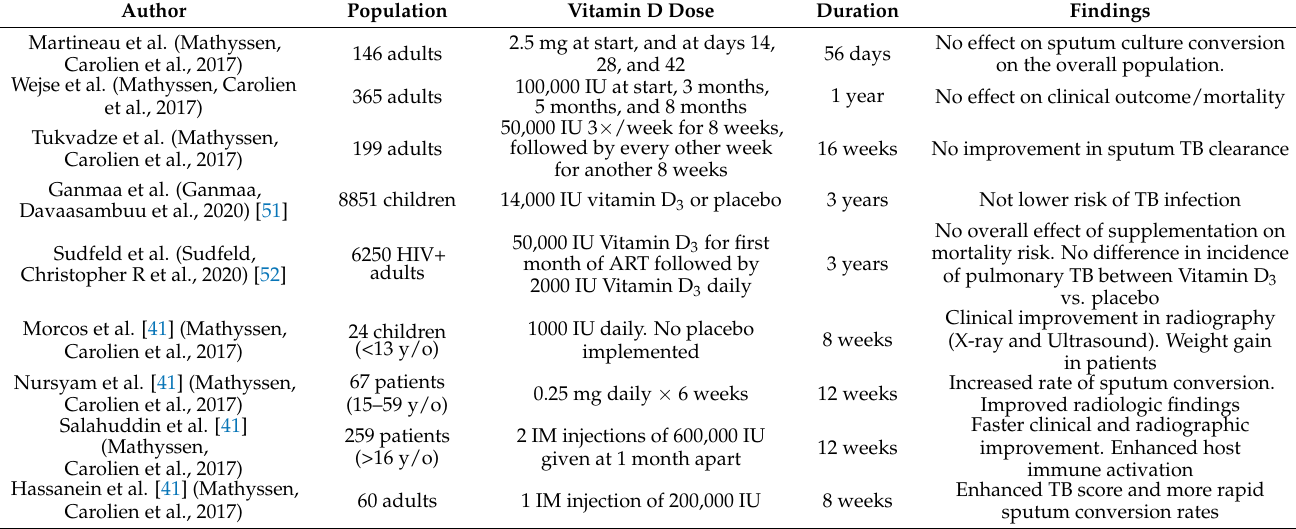
Figure 1. Immunomodulatory effects of 1,25 (OH) 2 D. Table 1. Overview of major clinical studies.